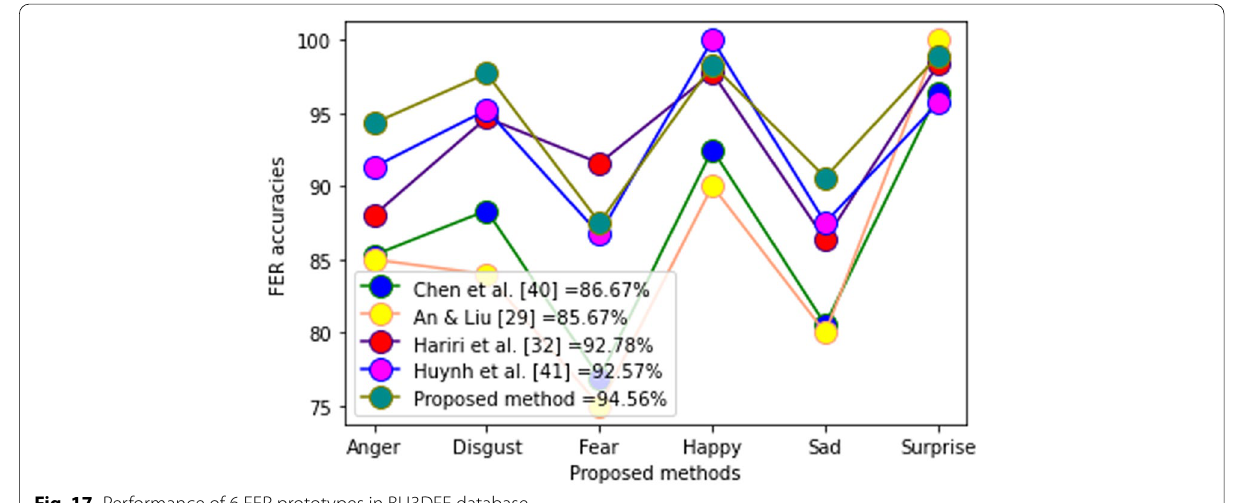
Fig. 17 Performance of 6 FER prototypes in BU3DFE database